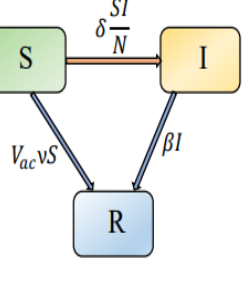
Figure 1. Graphical representation of the interactions between the various elements in the pro- posed